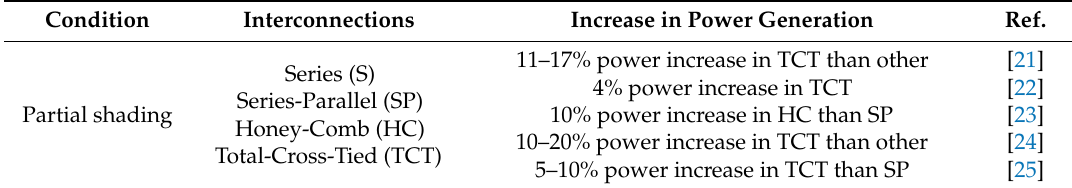
Table 1. Comparative analysis of shading condition in PV with respect to